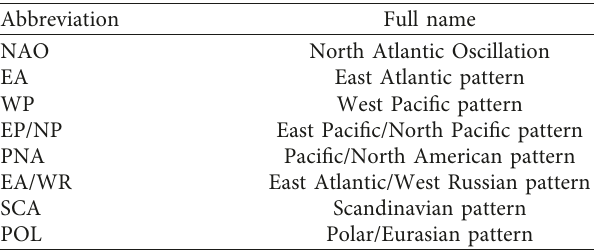
Table 1: Standardised Northern Hemisphere teleconnection in- dexes used in the